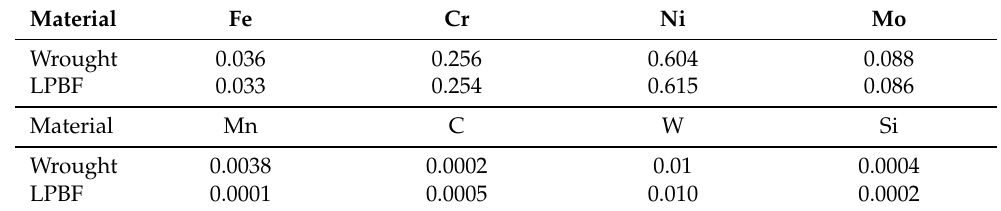
Table 1. Measured Atom Fractions in Wrought Alloy 22 and Alloy 22 Powder Used for